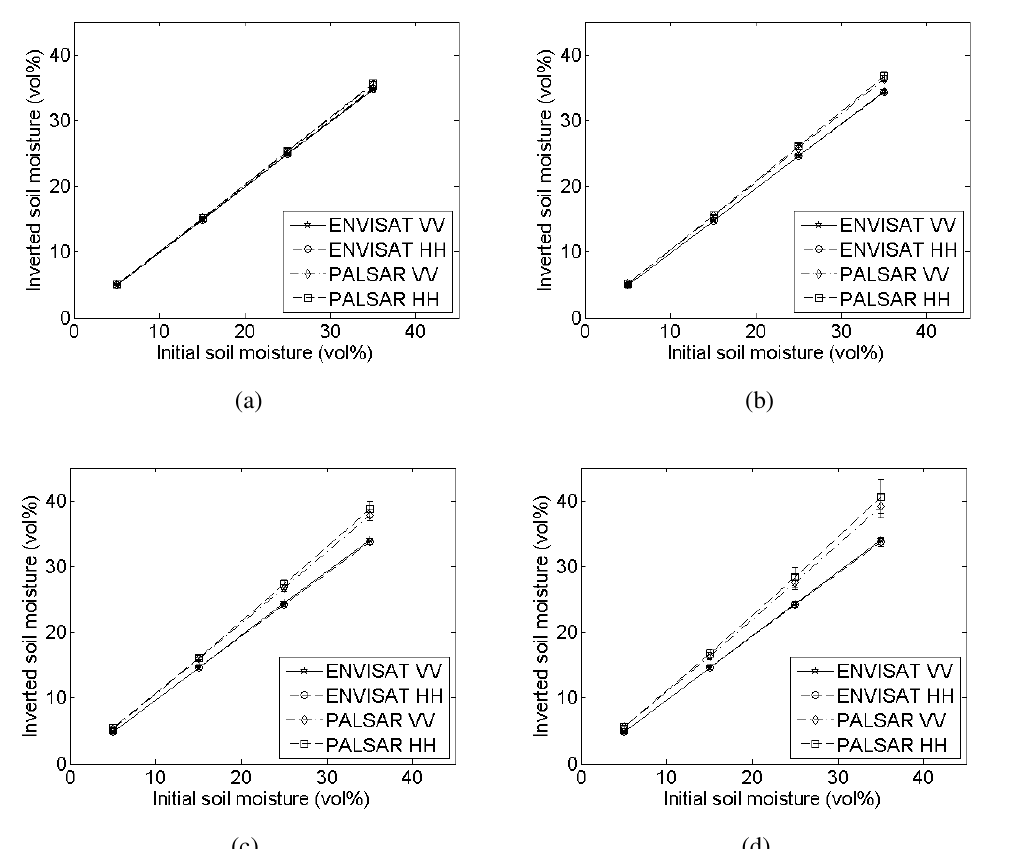
Figure 10. Mean and standard deviations of inverted soil moisture contents for different horizontal spacings used in the parameterization of roughness from 4-m profiles with ( s , l ) = (1 cm,5 cm). Considered spacings are (a) 2 mm, (b) 5 mm, (c) 10 mm and (d) 15